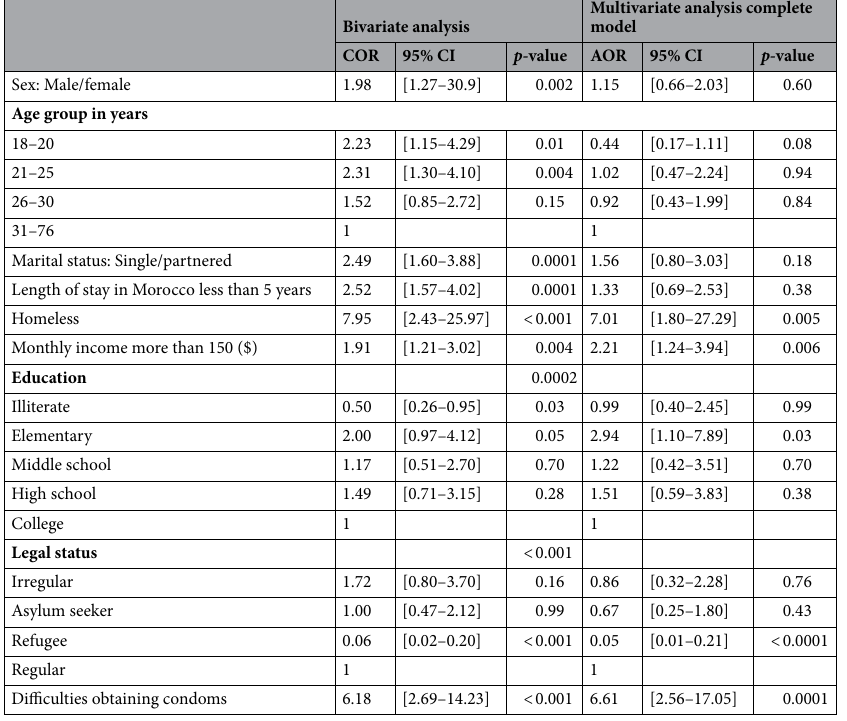
Table 3. Multivariate analysis (odds ratio, p -value) of risk factors of high-risk HIV sexual behaviors among sexually active migrants, Morocco, 2021. COR crude odds ratio, AOR adjusted odds ratio, CI confidence